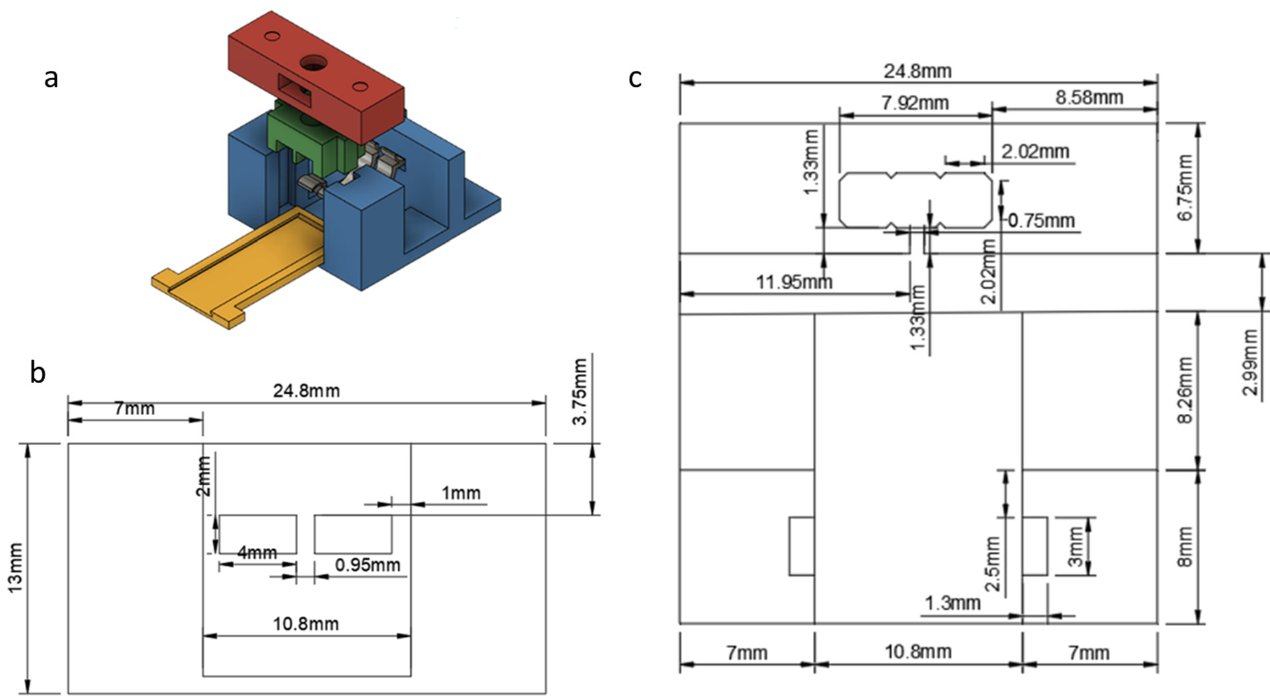
Figure 2. Design of the connector hosting the biosensor: ( a ) schematic; ( b ) front view; and ( c ) top